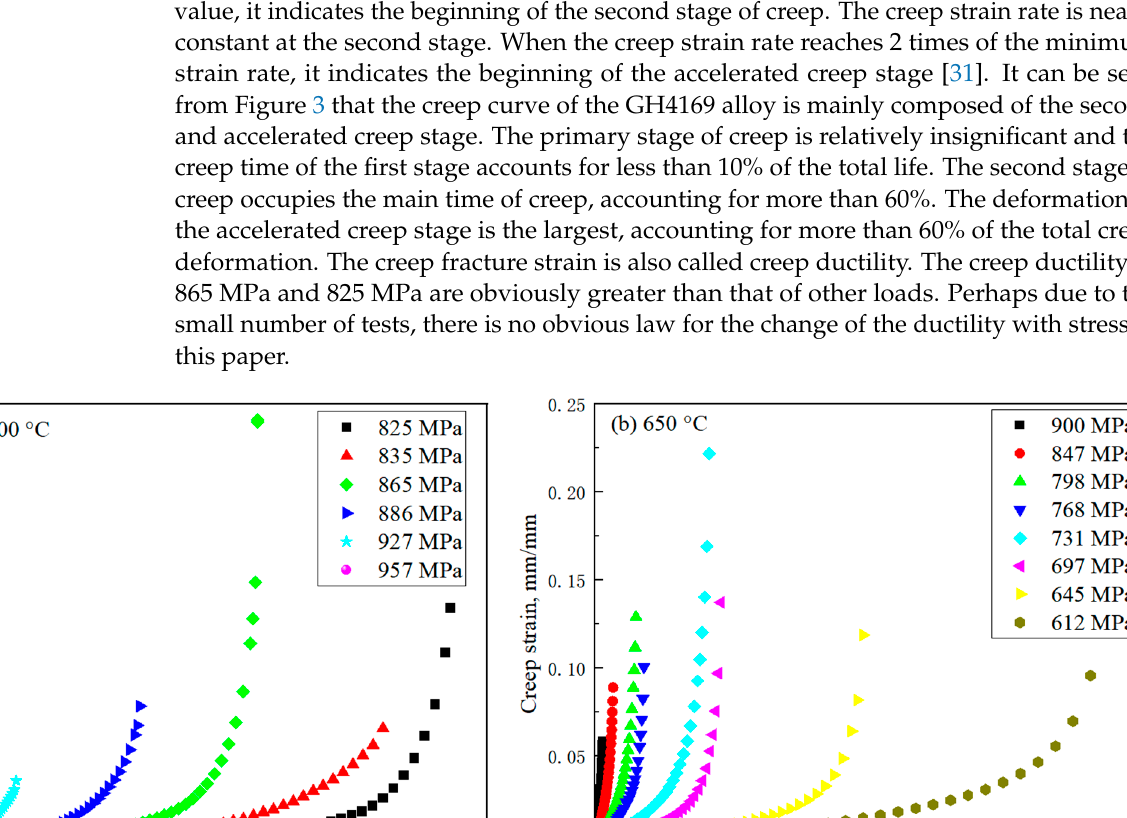
Figure 2. Tensile test results at different strain rates: ( a ) 2 × 10 3 /s; ( b ) 1 × 10 − 2 /s; ( c ) 5 × 10 − 4 /s; ( d ) 2 × 10 − 3 /s and 1 × 10 − 2 /s.